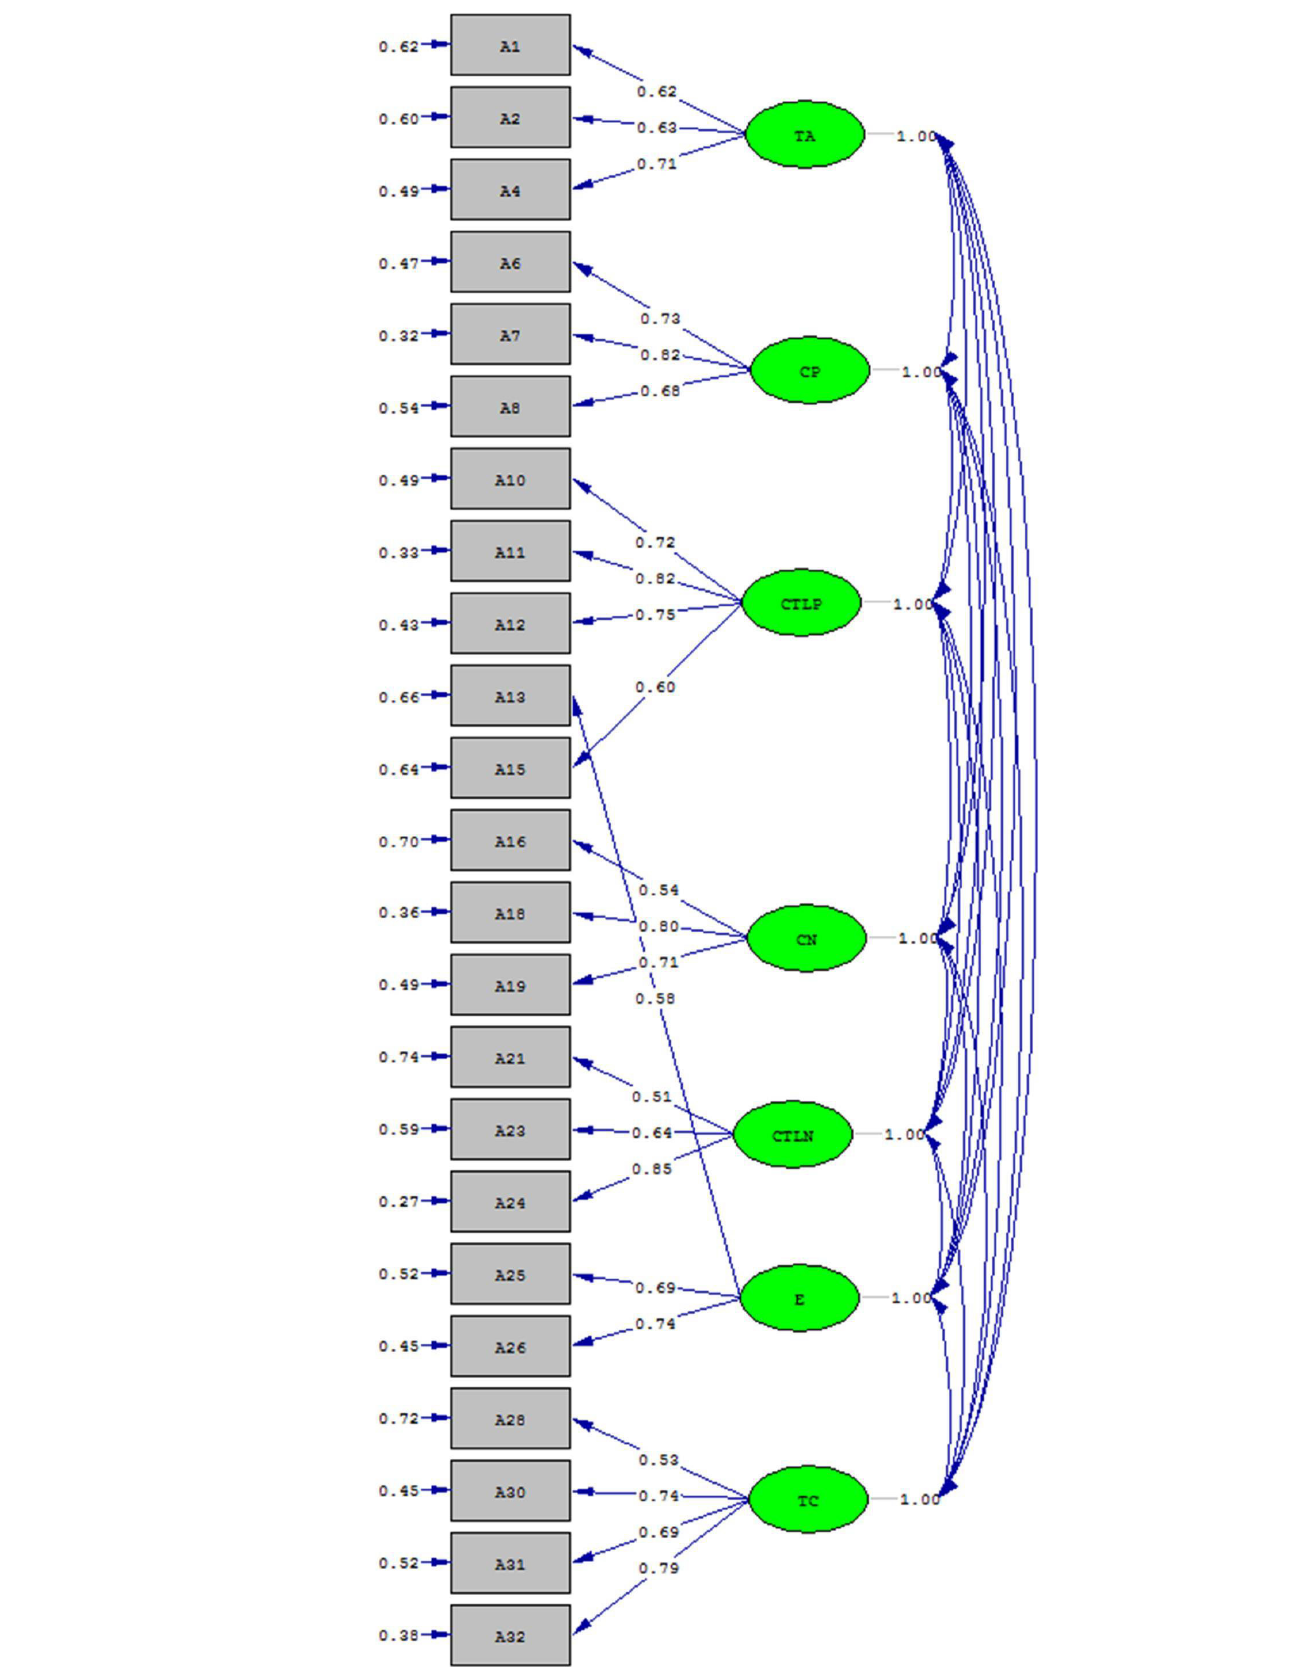
Figure 3. A graphic model of the Brazilian version of the